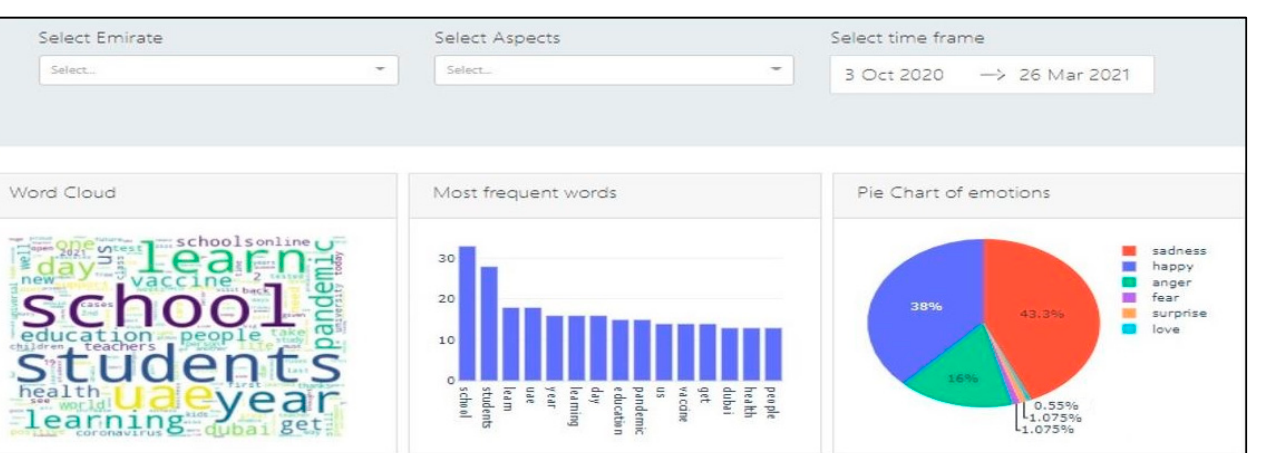
Figure 12. Testing Scenario#2.